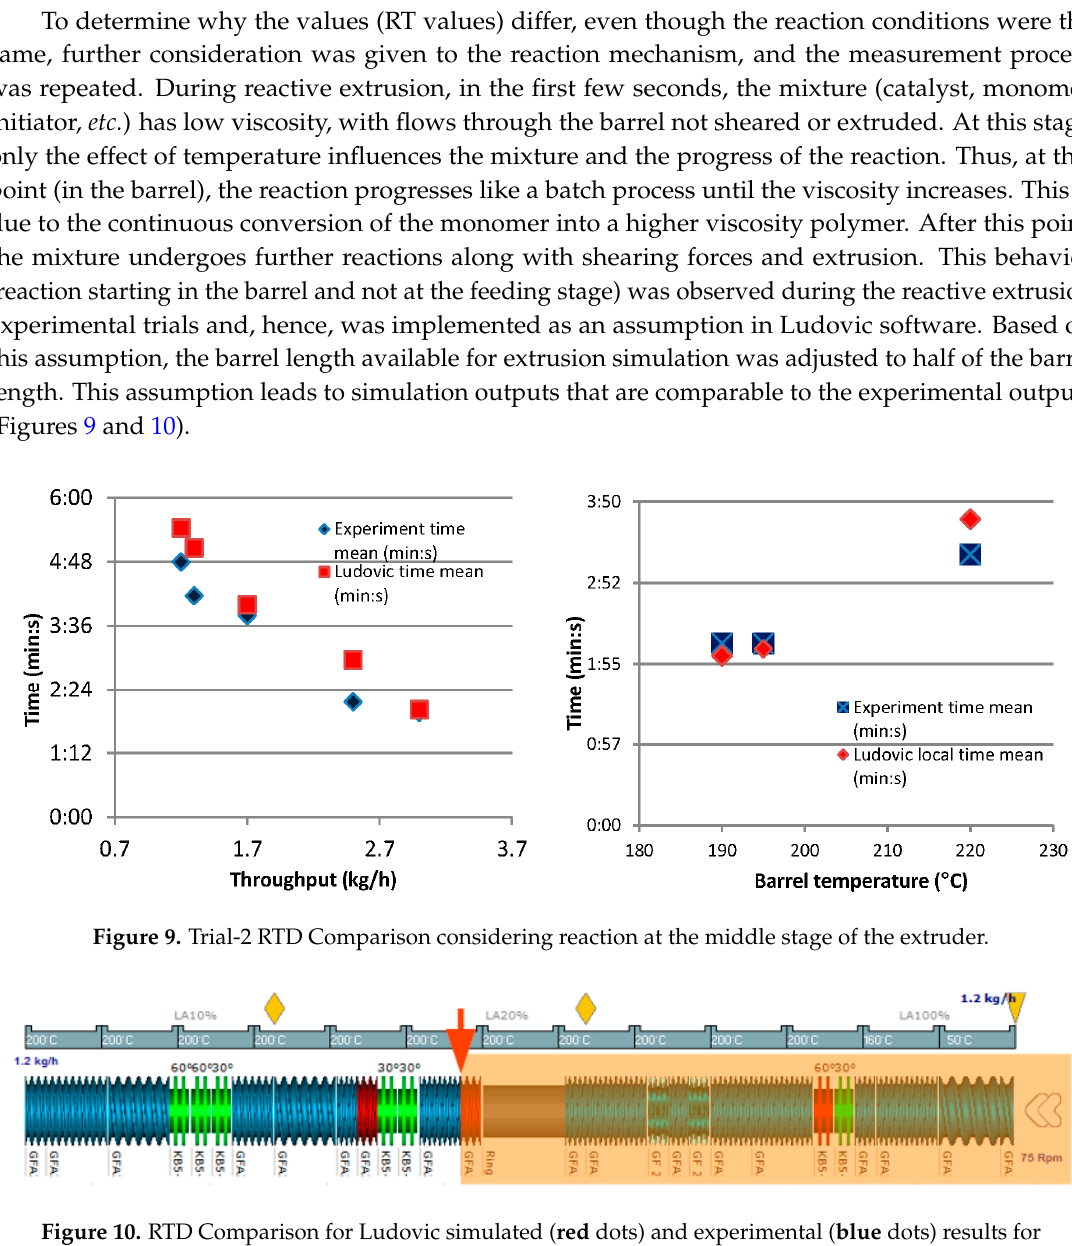
Figure 10. RTD Comparison for Ludovic simulated ( red dots) and experimental ( blue dots) results for throughput and barrel temperature.